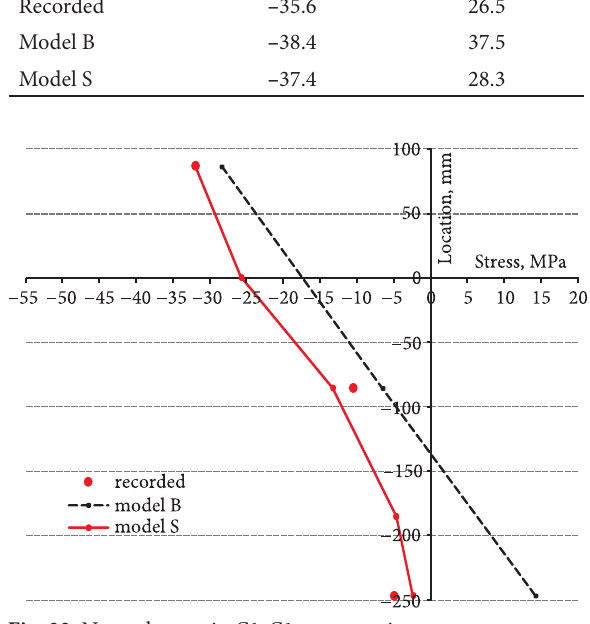
Fig. 23. Normal stress in C1-C1 cross-section